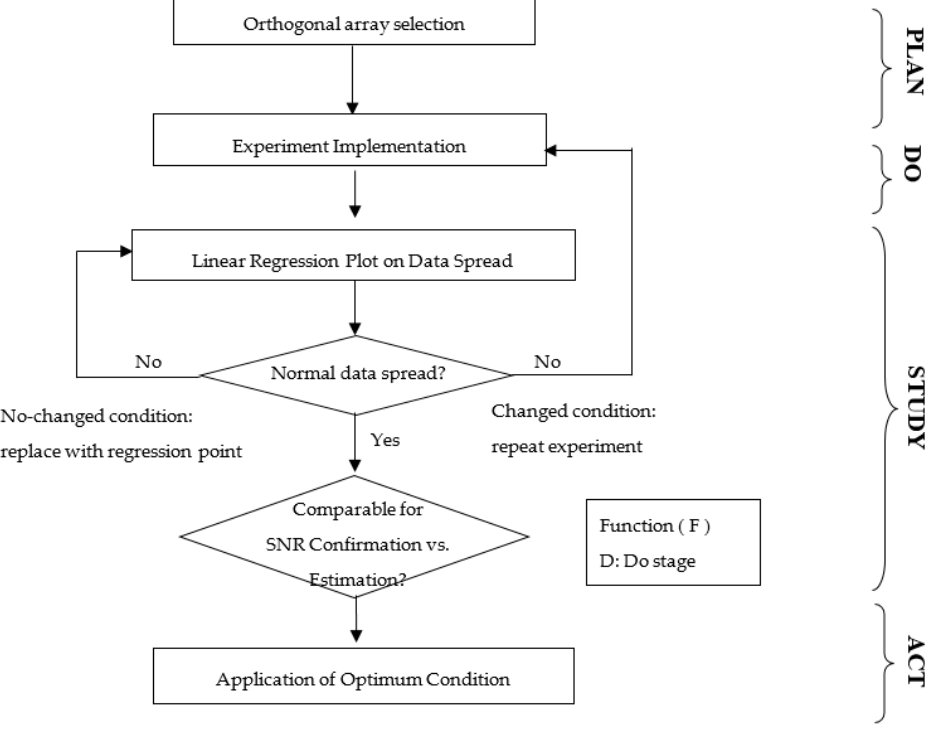
Figure 15. Optimization (O) sub-system of F-N-C-O.